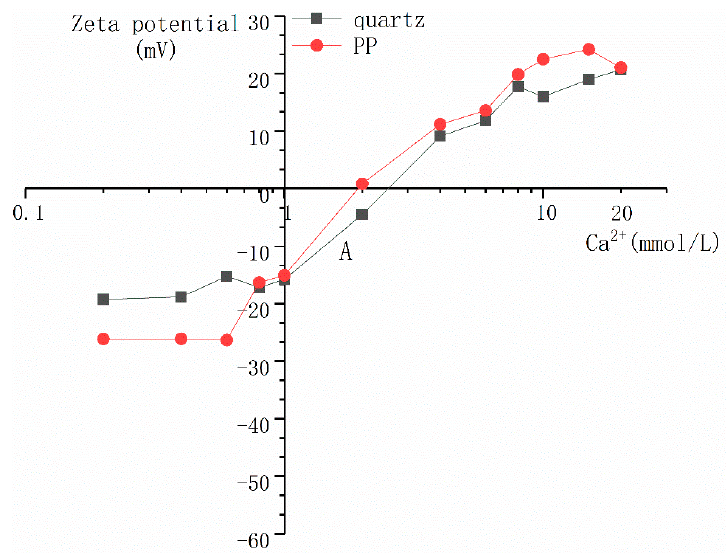
Figure 5. Evolution of the zeta potential of PP and quartz particles as a function of Ca 2 + concentration in Ca(OH) 2 solution.